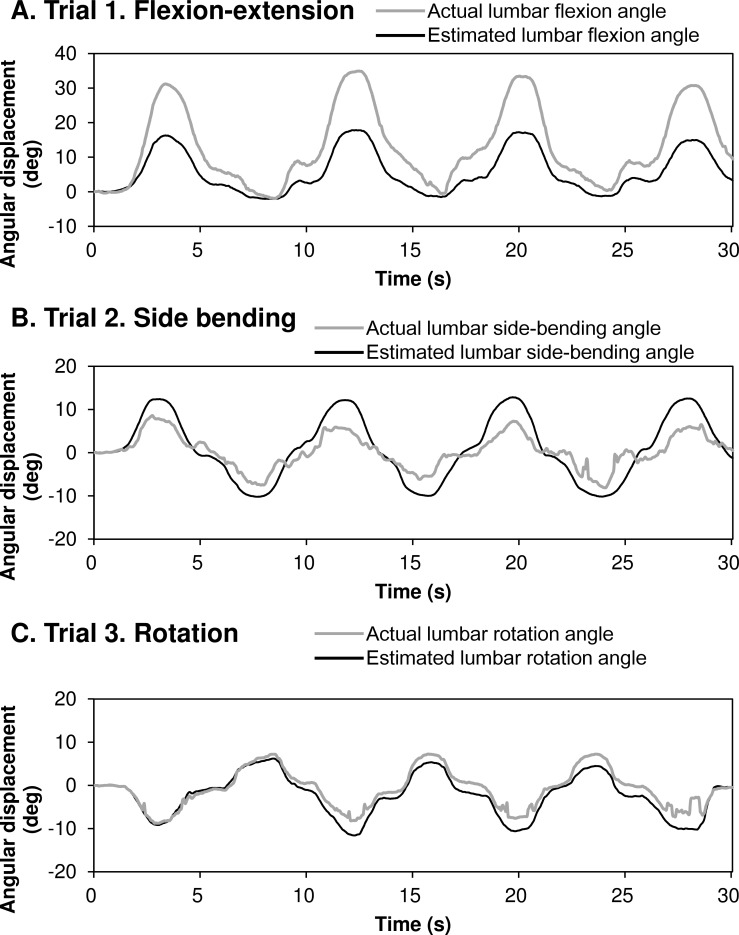
Representative angular displacements time series in uniaxial movements.Representative angular displacements for the (A) flexion-extension, (B) side-bending, and (C) rotation angles for the three uniaxial movement trials. The gray straight lines represent the angular displacement obtained from the optical motion capture system. The black straight lines represent the angular displacement estimated from the stretch sensor outputs.